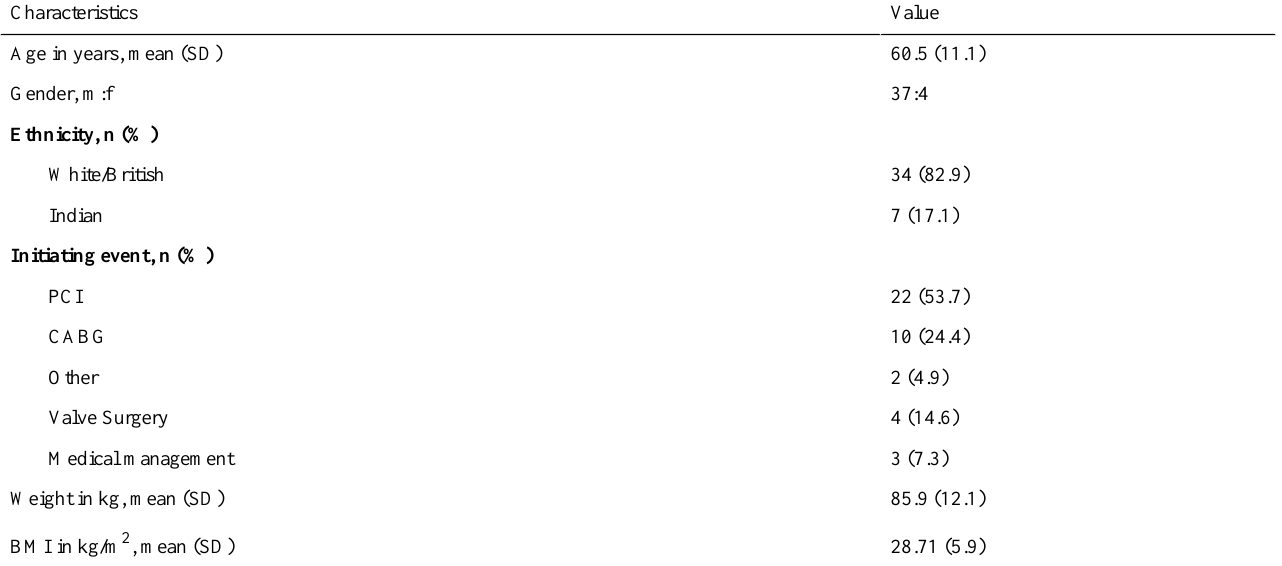
Table 1. Baseline characteristics for the participants in the pilot study (n=41).